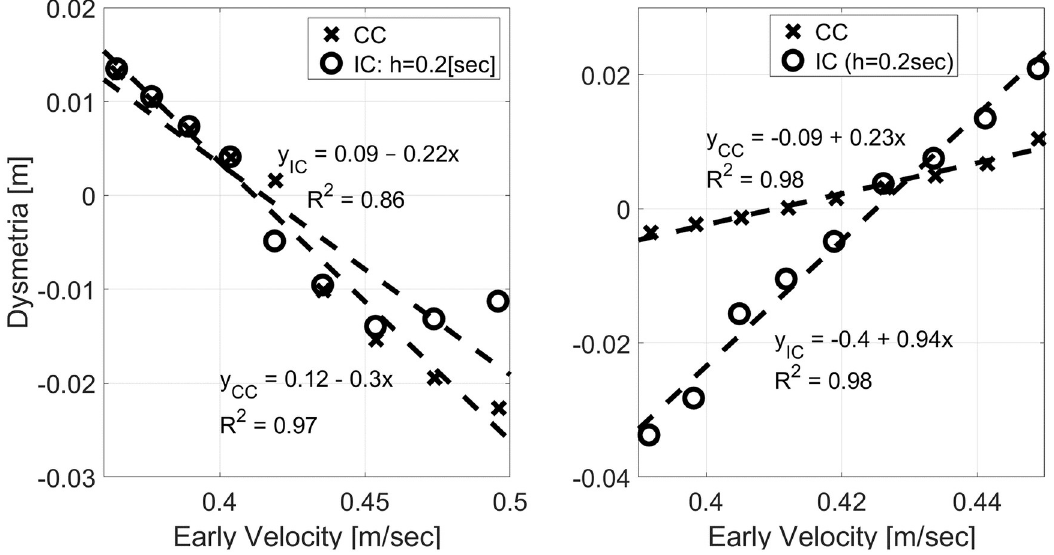
Fig 8. Dysmetria versus early velocity from simulations with inaccurate mass (left) or inaccurate damping ratio (right) for m IM = 2[Kg] and γ = 8[Nsec/m]. All simulations were conducted with τ = 0.15[sec]. IC was conducted with h = 0.2[sec]. Mass (left): IM m PL = (1.5, 2.5)[Kg] evenly spaced around m IM . Damping ratio (right): γ PL 2 (6, 10)[Nsec/m] evenly spaced around γ IM